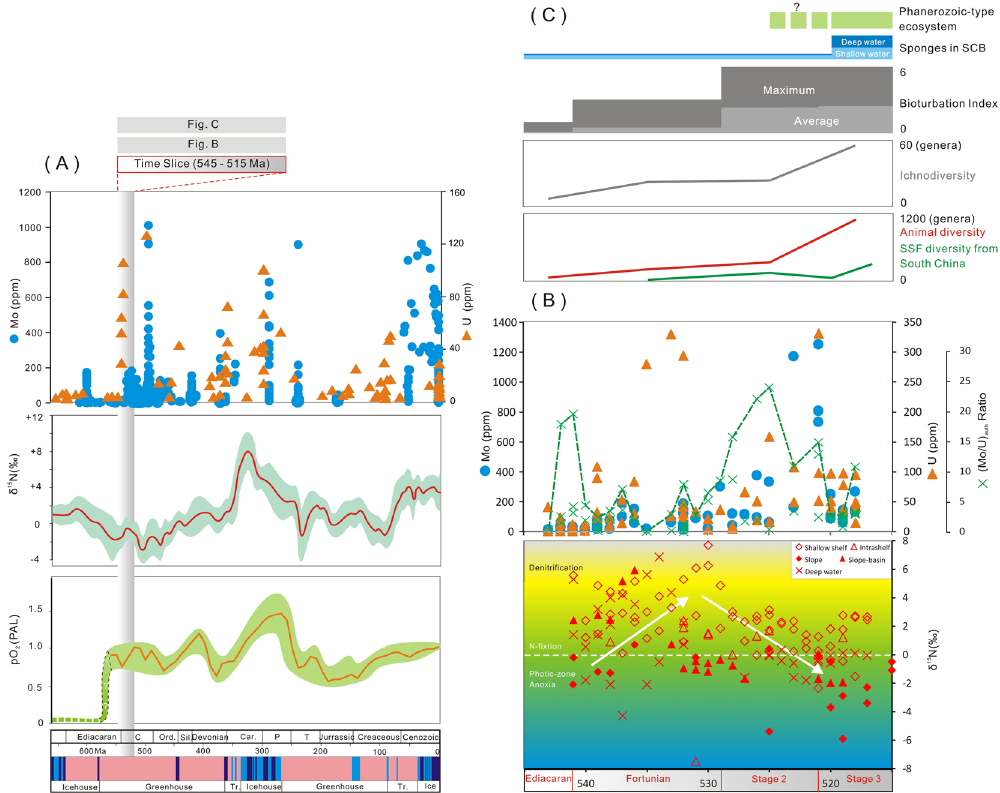
Figure 6. Integrated compilation of diverse geochemical indices with the biodiversity data. ( A ) Geochemical indices through geologic time. Mo concentrations were picked from refs 4 and 14, and time-averaged U concentrations were selected from the data of ref. 5, including data of this investigation. The composite curve of secular trends of δ 15 N are according to ref. 24. The curve of atmospheric oxygen levels relative to present is according to refs 2, 3 and 7. ( B ) Concentrations of Mo and U and Mo EF /U EF through time (541–515 Ma); compilation of δ 15 N values from a range of depositional environments in the Early Cambrian Yangtze Sea (541–515 Ma). N isotopes are compiled from refs 20, 21 and this study. ( C ) Comparative bioturbation index and ichnodiversity data (referred to ref. 13); animal diversity from ref. 42 and SSF diversity data from ref. 43. The ages of glacial and green-house intervals are according to ref. 24. The white arrows in ( B ) represent the overall variation tendency of δ 15 N